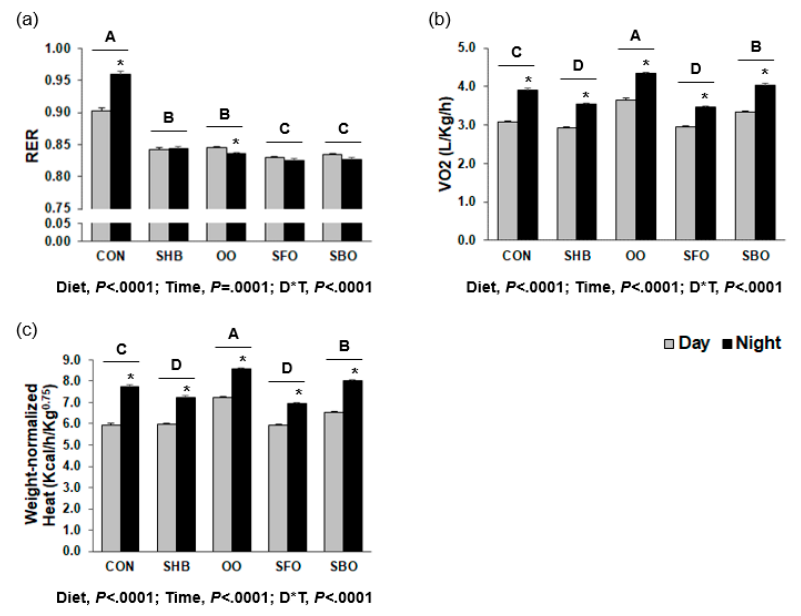
Figure 1. Indirect calorimetry ( a ) Respiratory exchange ratio (RER) ( b ) O 2 consumption ( c ) Weight-normalized heat generation. CON, control; SHB, shea butter; OO, olive oil; SFO, safflower; SBO, soybean oil. After eight weeks of feeding the experimental diets, O 2 consumption and CO 2 production of mice were measured for three days using the Oxymax open circuit indirect calorimeter. Data were separated into day or night time for each diet. Bars represent means ± SEM ( n = 4 for each diet group). Diets were compared among each other (after combining day and night data within each diet), and assigned different superscripts A, B, C, or D) if they were significantly different from each other at P < 0.05 by Tukey’s multiple comparison test. D*T, Interaction effect between diet and time. Asterisks (*) indicate significant differences due to time effect (day or night time) within each diet group when diet*time interaction effect was significant by ANOVA.